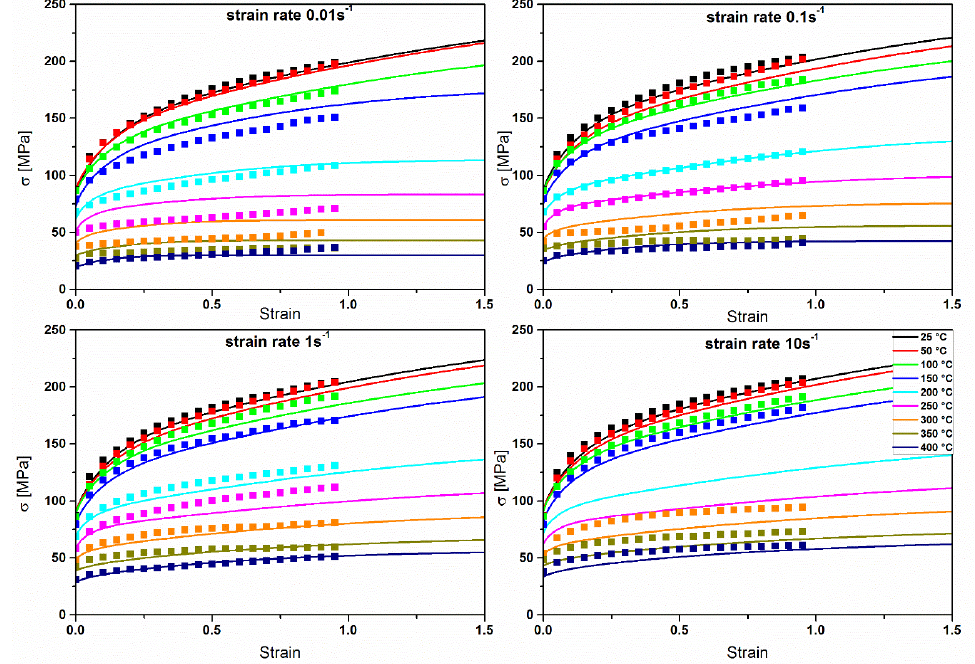
Figure 10. Measured (squares) and modelled (lines) flow stress at different strain rates and for temperatures ranging from 25 °C to 400 °C.